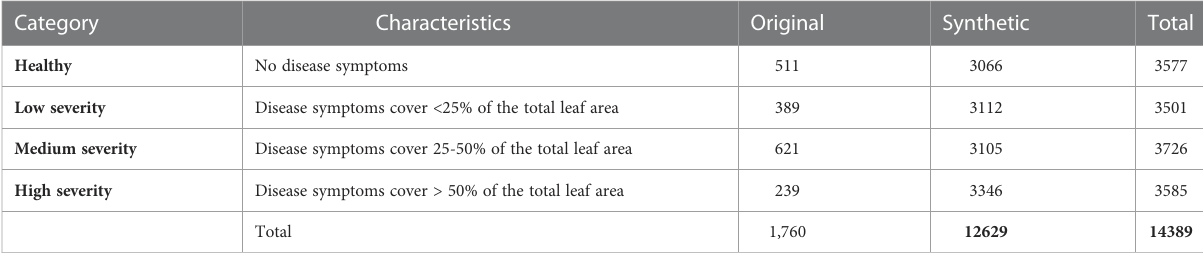
TABLE 2 Categorization and summary of images of MDSD database. Category